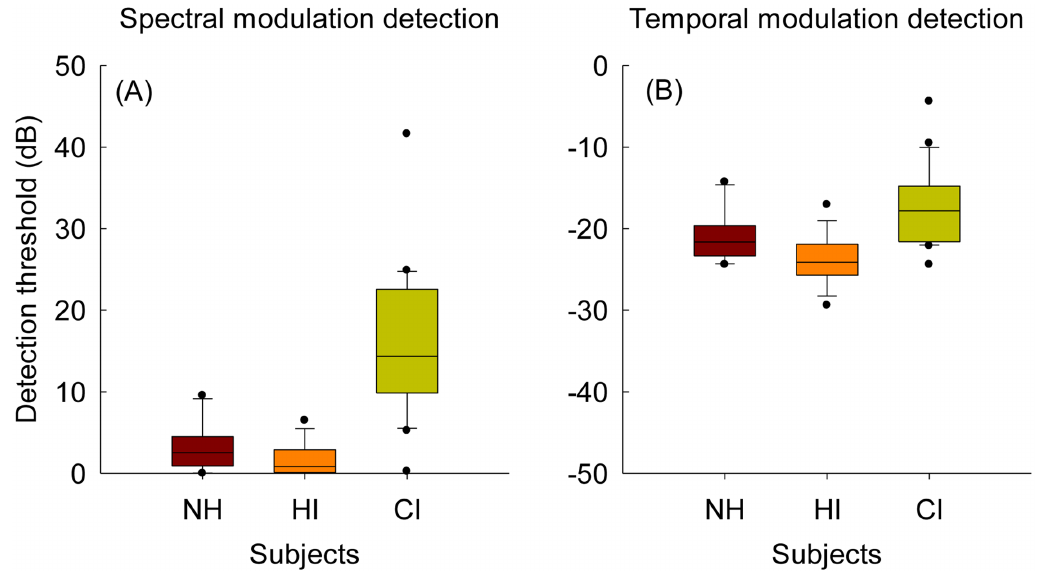
Fig 6. Boxplots for spectral modulation detection at 1 c/o (A) and temporal modulation detection at 10 Hz (B) for NH, HI, and CI subjects.